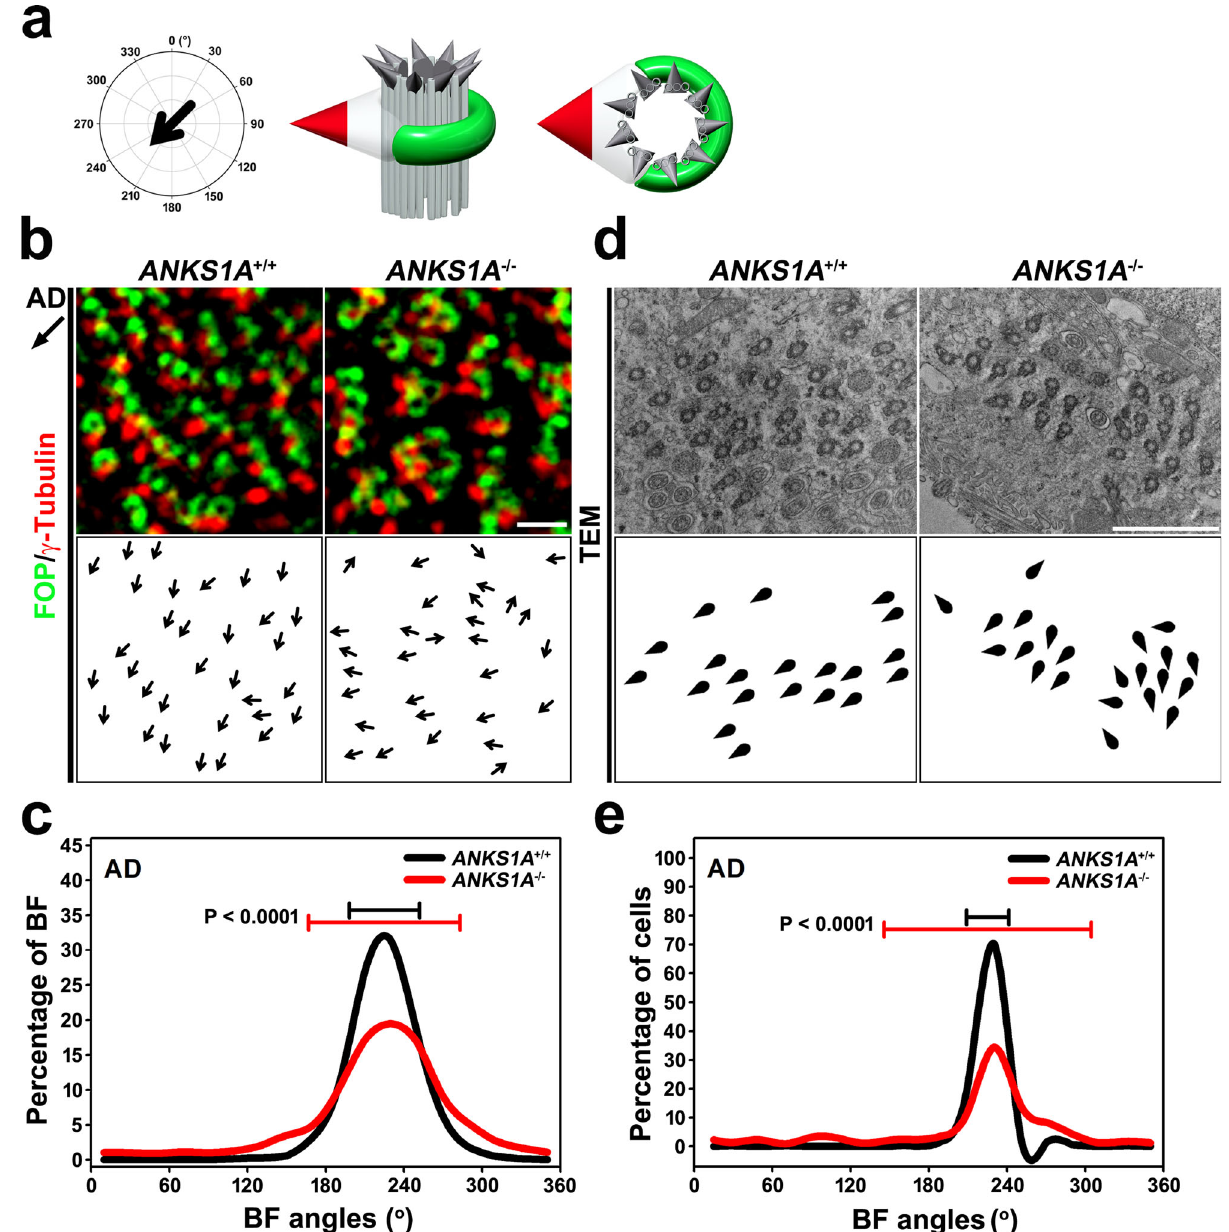
Fig. 4 ANKS1A loss results in defective rotational polarity. a Schematic depicting the fl ow of CSF (225°) in the AD region. Double staining for FOP (green, SDA marker) and γ -Tubulin (red, BF marker) to visualize rotational polarity. b Images of the AD region obtained by 3DSIM, and BBs magni fi ed for rotational polarity analysis (top panels). Each black arrow points from the FOP staining toward the γ -Tubulin-positive dot, indicating the rotational polarity axis of each individual BF (bottom panels). Scale bar, 1 μ m. c Histogram showing the distribution of the rotational vector angles. Error bars on the graph represent CSD. d En face electron micrographs from the apical surface of ANKS1A WT and KO samples (top panels). Schematics showing the BBs (circular) with BFs (triangular) appear in the bottom panels. Scale bar, 2 μ m. e The TEM data shown in d were used to draw histograms. Error bars on the graphs represent